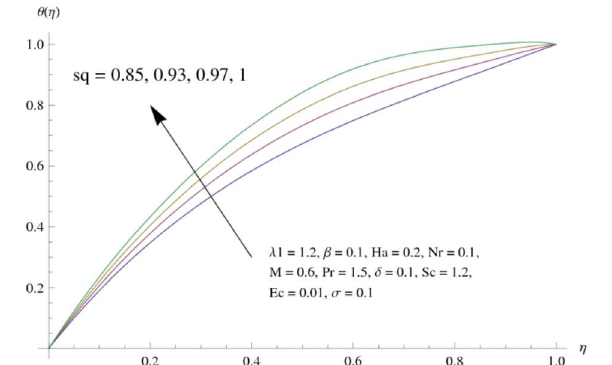
FIGURE 7 | Behavior of S q on θ ( η ).